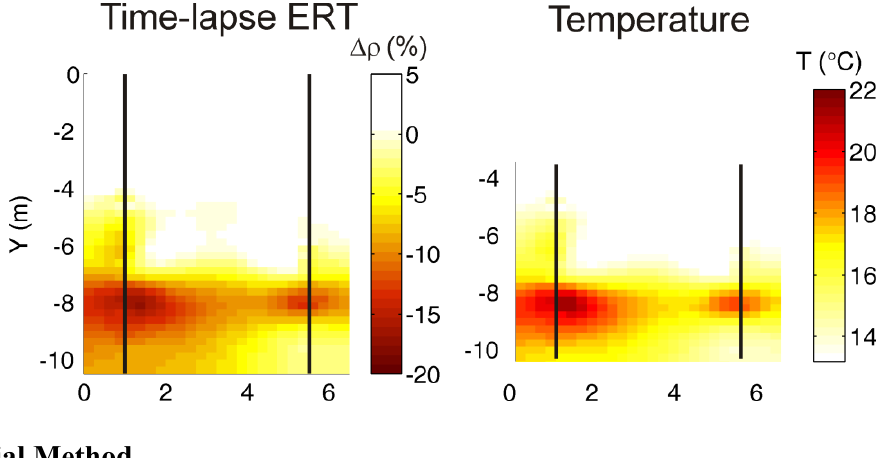
Figure 4. Time-lapse tomography of changes in temperature derived from ERT using Equation (13) on Figure 3, left. The image of temperature is limited to the saturated zone, because Equation (5) is not valid in the unsaturated zone (modified after